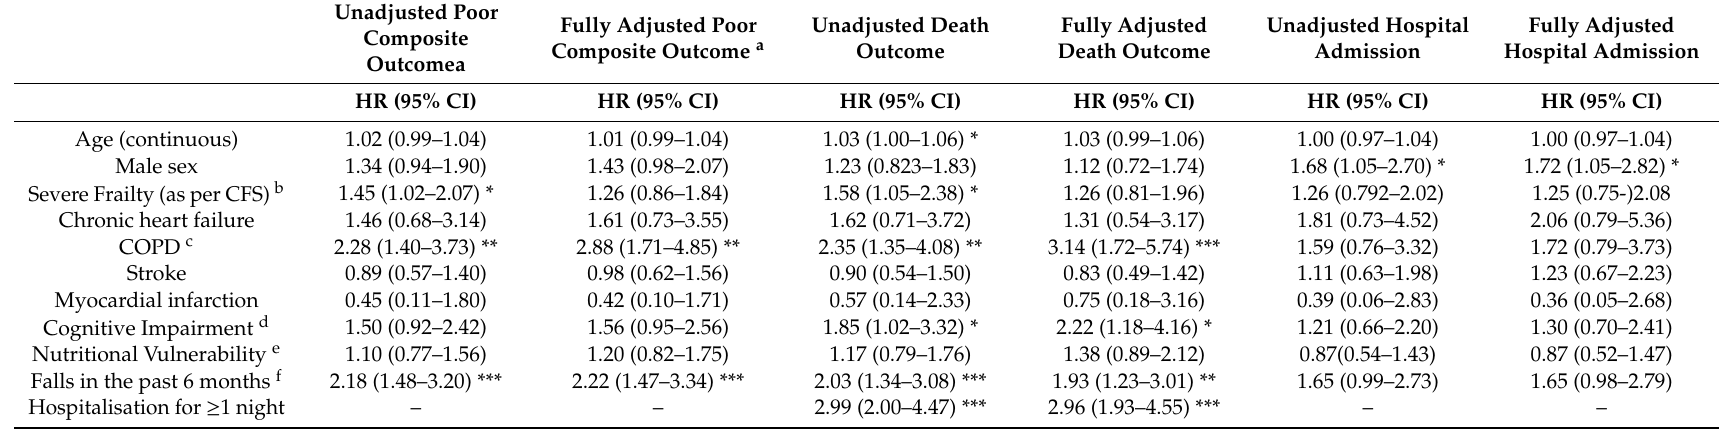
Table 2. Unadjusted and adjusted (full initial model) analysis for predictors of poor composite outcome, and single outcome of death or hospital